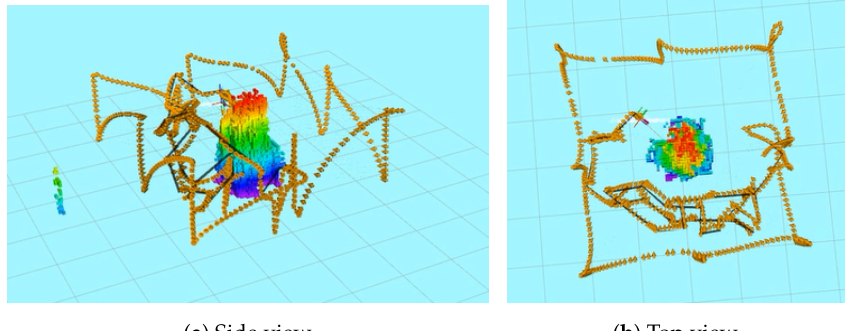
Figure 13. The path followed by the UAV shown in orange color including the profiling stage. The planned trajectory is shown in black and the reconstruction of the processed point cloud shown using OctoMap voxels.